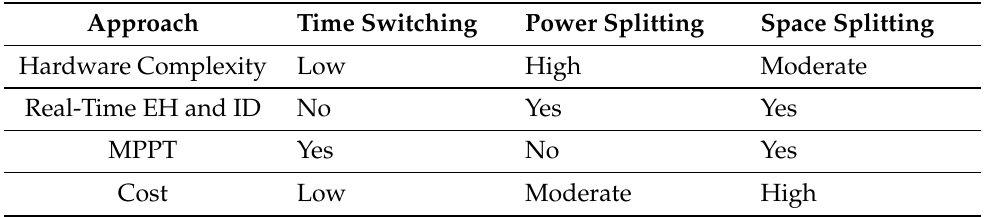
Table 1. Comparison between different SLIPT